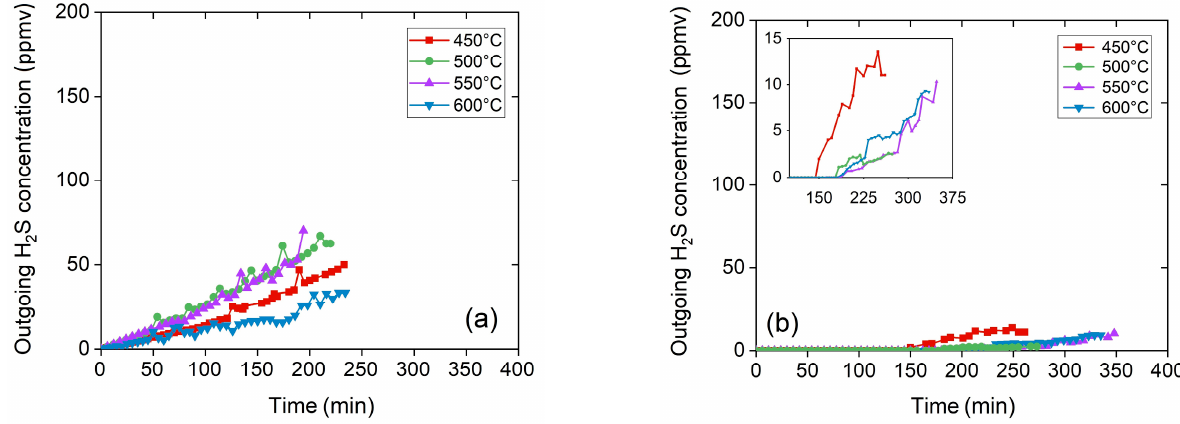
Figure 3. Outgoing H 2 S concentration vs. time plot at different temperatures (450, 500, 550, and 600 °C) considering a GHSV equal to ( a ) 50000 h − 1 and ( b ) 25000 h − 1 considering a gas flow of 305 NmL min − 1 .